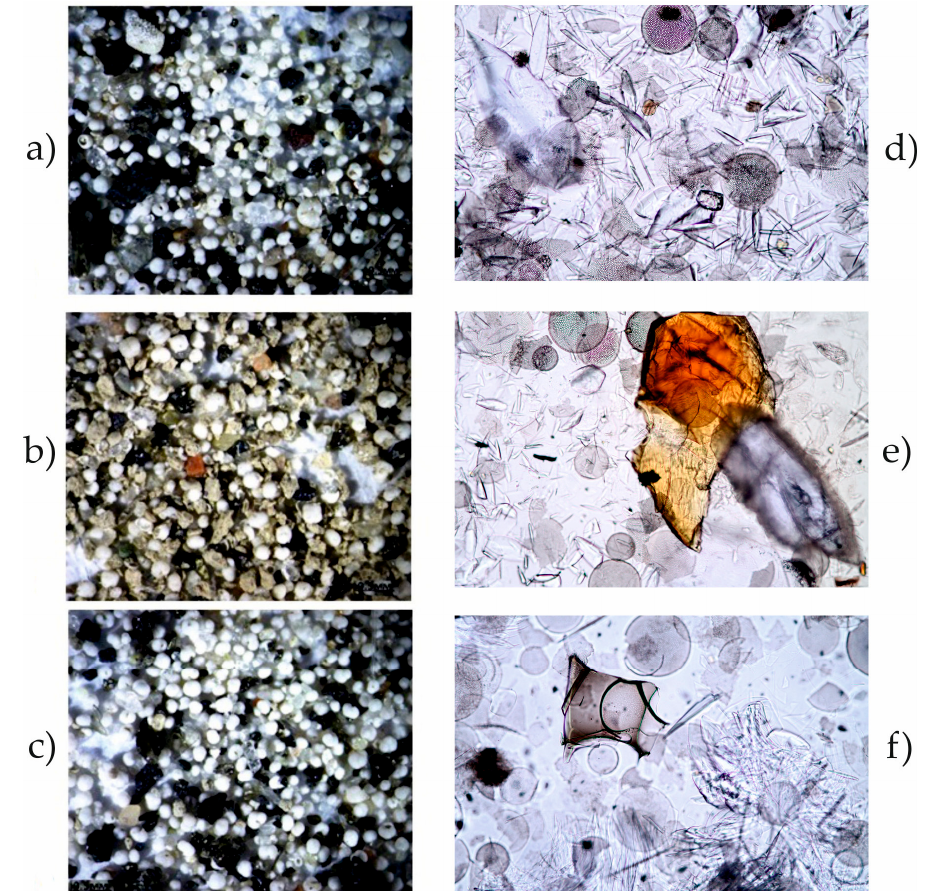
Figure 3. Microphotographs of the sediment samples of the core AMK-340. Left panel present photos of the sediment fraction > 0.1 mm under the stereomicroscope: ( a ) core sample of 323–325 cm, ( b ) sample of 328–330 cm, ( c ) sample of 338–340 cm. Right panel present photographs of the sediment fraction > 0.05 mm under the transmitted light microscope: ( d ) core sample of 323–325 cm, ( e ) sample of 328–330 cm, ( f ) sample of 338–340 cm. The regular microphotographs of the sediment fractions were obtained with the stereomicroscope Zeiss Stemi 508 equipped with the camera AxioCam Icc5 (left panel), and the transmitted light microscope used was the Zeiss Axio Lab.A1 powered by the Canon EOS 1100D camera (right panel). Table 1. The number of shards and measurements in the studied samples of the core AMK-340. Shards in Polished Measurements Measurements in Core Sample, cm Shards in Total Thin Sections in Total Polished Thin